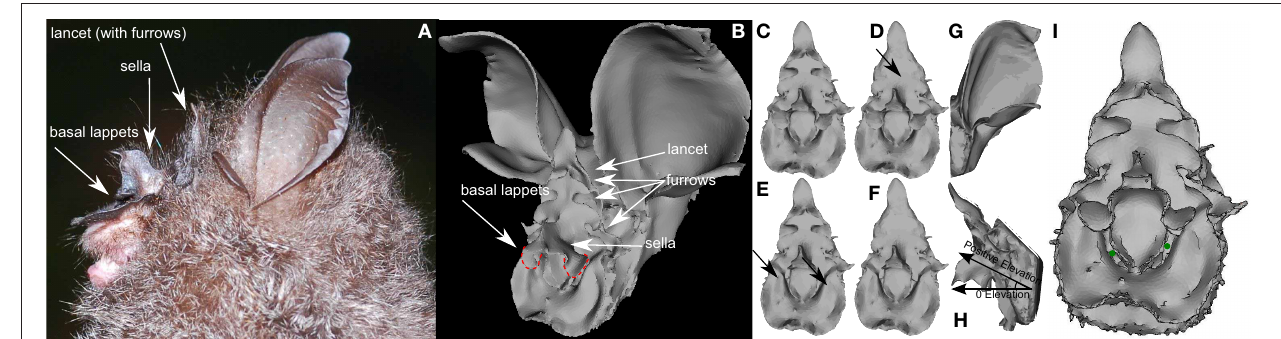
FIGURE 1 | Rendering of the 3D models of the noseleaf and pinna of Rhinolophus formosae used to simulate the emission and hearing beam patterns. (A) Photo of R. formosae (courtesy of Chun-Wei Hsie). (B) Rendering of complete head model from which the noseleaf model (C–F) and the pinna model (G) were derived. In panels (A,B) the different parts of the noseleaf have been indicated. In panel (B) the basal lappets have been circled. (C) Original noseleaf model. (D) Model with filled furrows